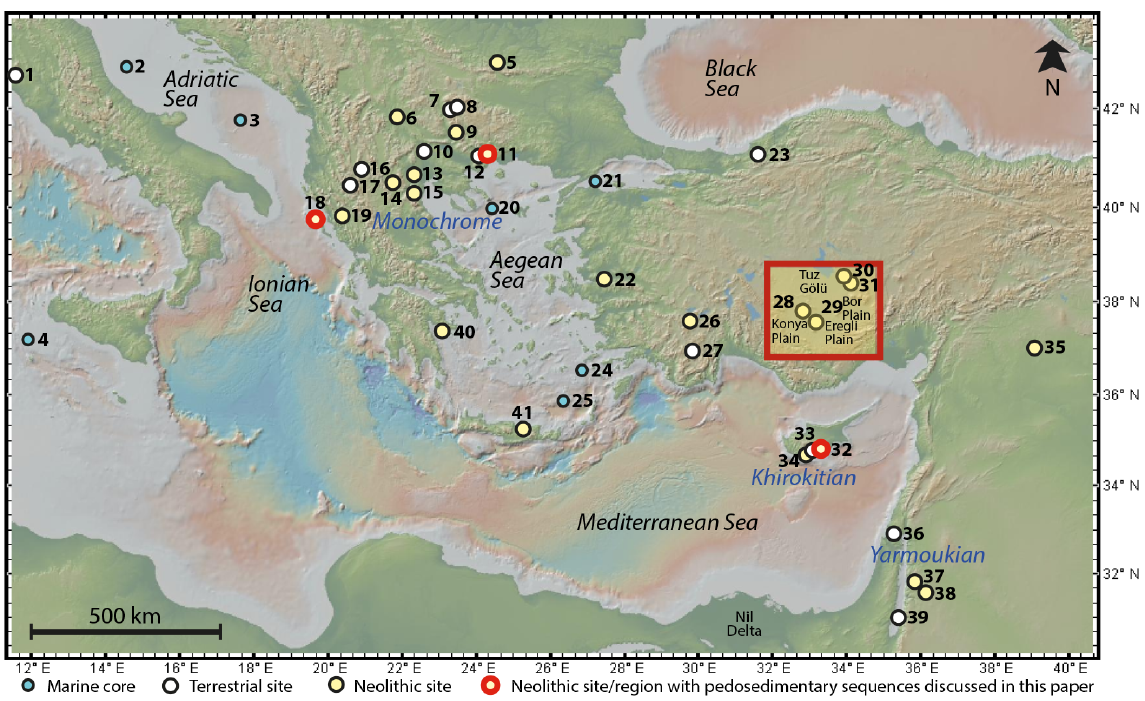
R uljunica; 6, Anzabegovo; Figure 2. Map of main sites cited in the text: 1, Lake Accesa; 2, CM-92-43; 3, MD90-917; 4, MD 04-2797; 5, D 7, Lake Trilistnika; 8, Lake Ribno; 9, Kovacevo; 10, Lake Dojran; 11, Dikili Tash; 12, Tenaghi Philippon marsh; 13, Nea Nikomedia; 14, Mavropigi-Filotsairi; 15, Paliambela; 16, Lake Prespa; 17, Lake Maliq; 18, Sidari 1/2; 19, Konispol Cave; 20, SL-152; 21, KL-71; 22, Ulucak; 23, Sofular Cave; 24, NS-14; 25, LC-21; 26, Hacilar; 27, Lake Golishar; 28, Çatalhöyük; 29, Can Hasan; 30, Musular; 31, A¸sıklı; 32, Khirokitia-Maroni River; 33, Vasilikos Valley; 34, Shillourokambos; 35, Tell Sabi Abyad; 36, Soreq Cave; 37, Wadi Shu’eib; 38, Ain Ghazal; 39, Dead Sea; 40, Franchthi Cave; 41, Knossos. Main Neolithic cultures of the 9th millennium cal BP are in